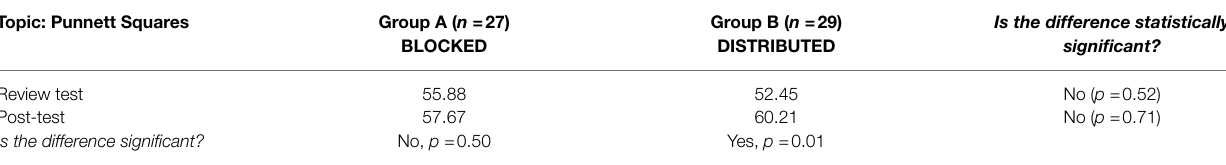
TABE 5 | Comparing 7th grade biology classes using blocked practice vs distributed retrieval practice.